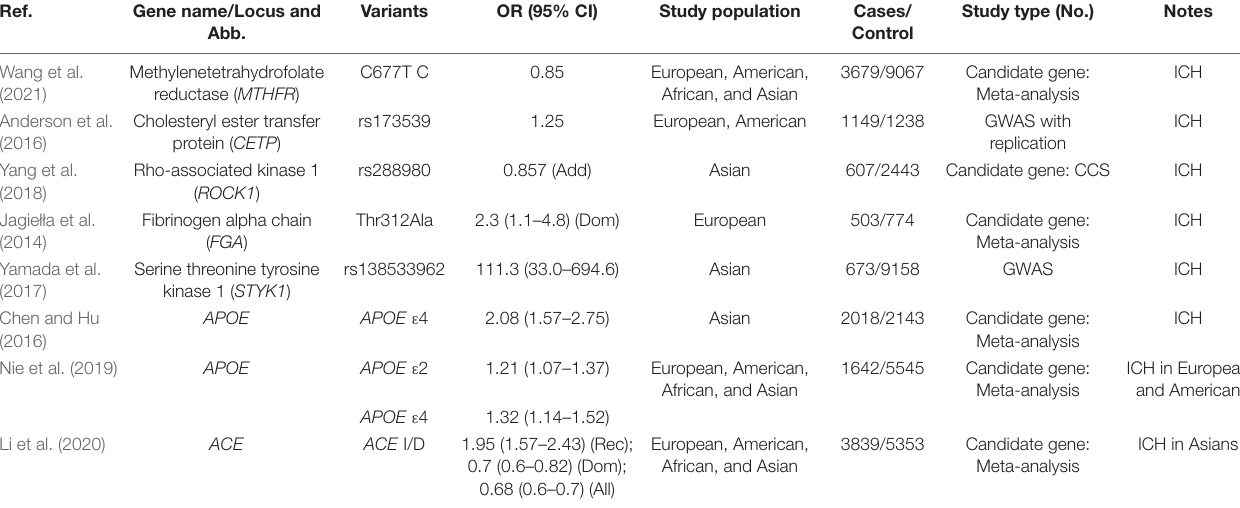
TABLE 3 | Well-proved genetic variants related to LICH/DICH risk.